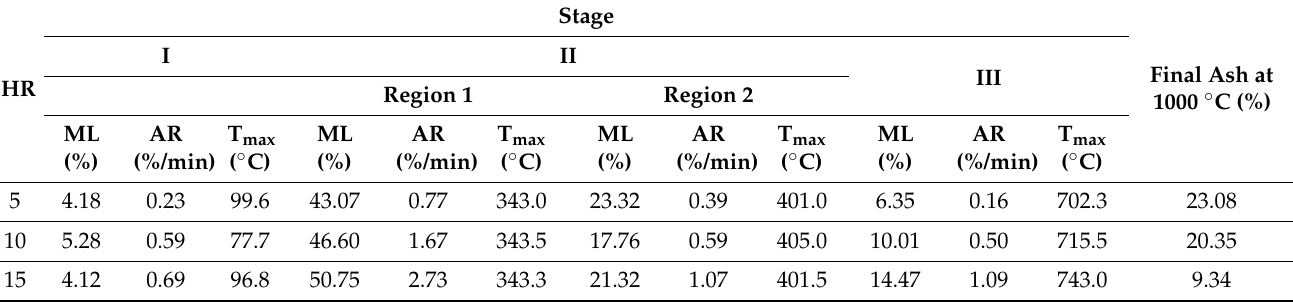
Table 3. Kinetics data for sample decomposition at different